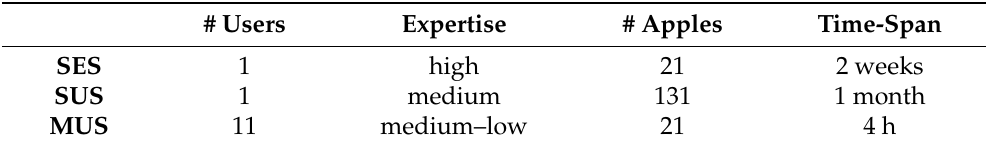
Table 2. Metadata of the three user studies: Single-Expert Study (SUS), Single-User Study (SUS), and Multiple-User Study (MUS).